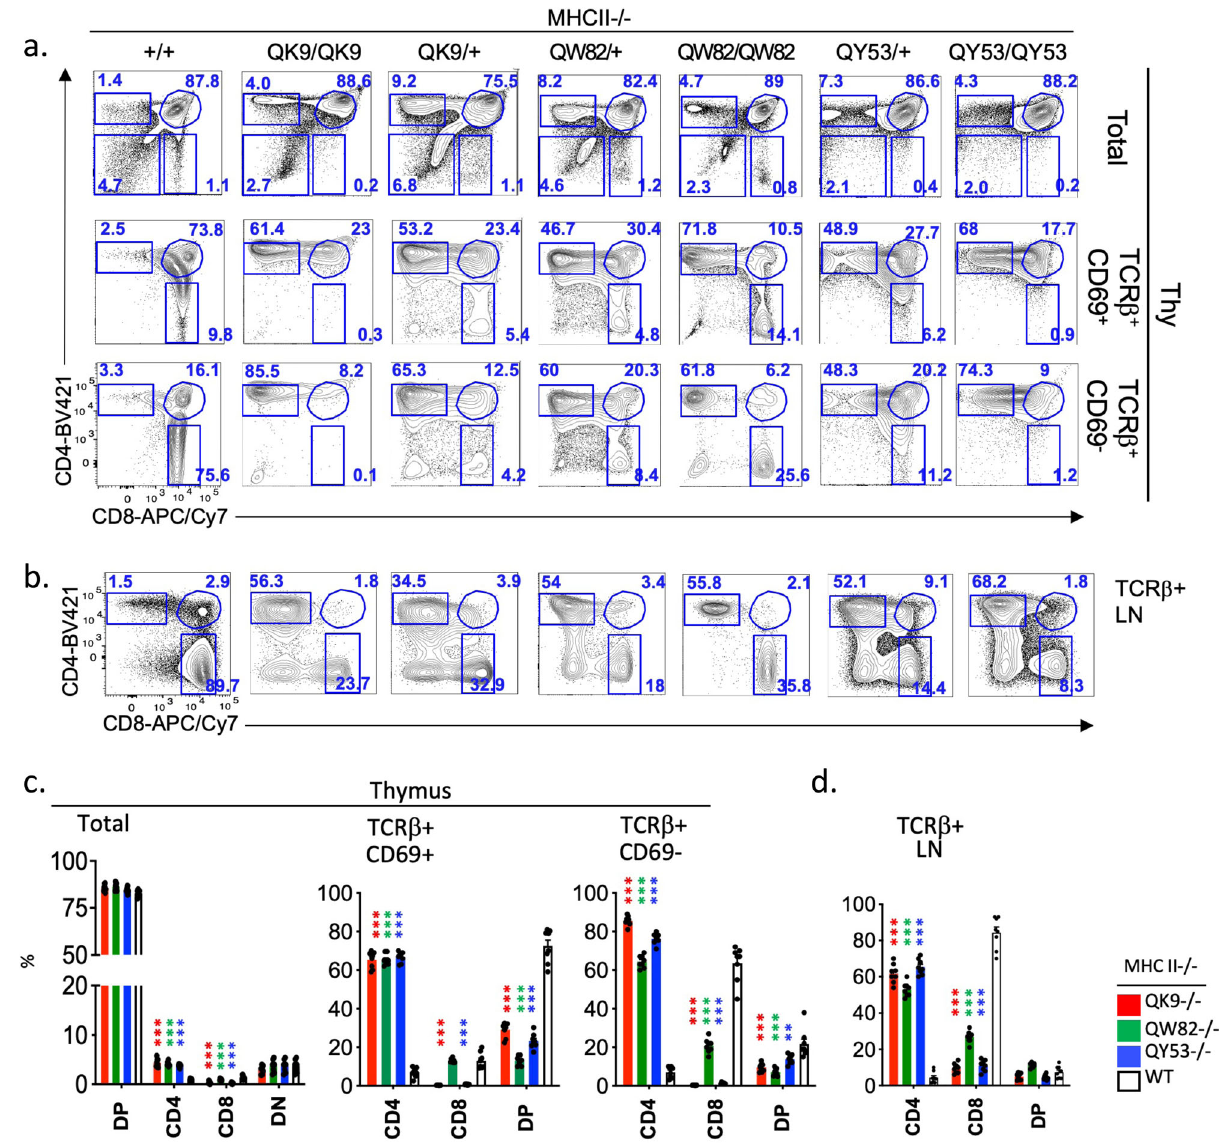
Fig. 8 Mutation of EGR and NFAT-binding motifs adjacent to conserved Runx sites impairs normal lineage choice of MHC class I-restricted thymocytes. a , b FACS analysis of TCR β , CD69, CD4, and CD8 expression of total thymocytes, gated thymocytes ( a ), and peripheral T-cell subsets ( b ) of wt, or mutant mouse lines crossed to MHC II − / − background. c , d Plots showing % of DP, SP CD4, SP CD8, and DN thymocytes for mice of indicated genotypes. N = 6 independent animals per strain. Data are presented as mean values + / − SEM. A P value < 0.05 was considered signi fi cant. Statistical signi fi cance was determined between mutant mice and ThPOK + / + mice on MHC II − / − background by one-way ANOVA with post hoc Tukey HSD, and indicated by asterisks (* P < 0.01; ** P < 0.005; *** P < 0.001). Statistical signi fi cance was calculated for each indicated mutant line relative to wt